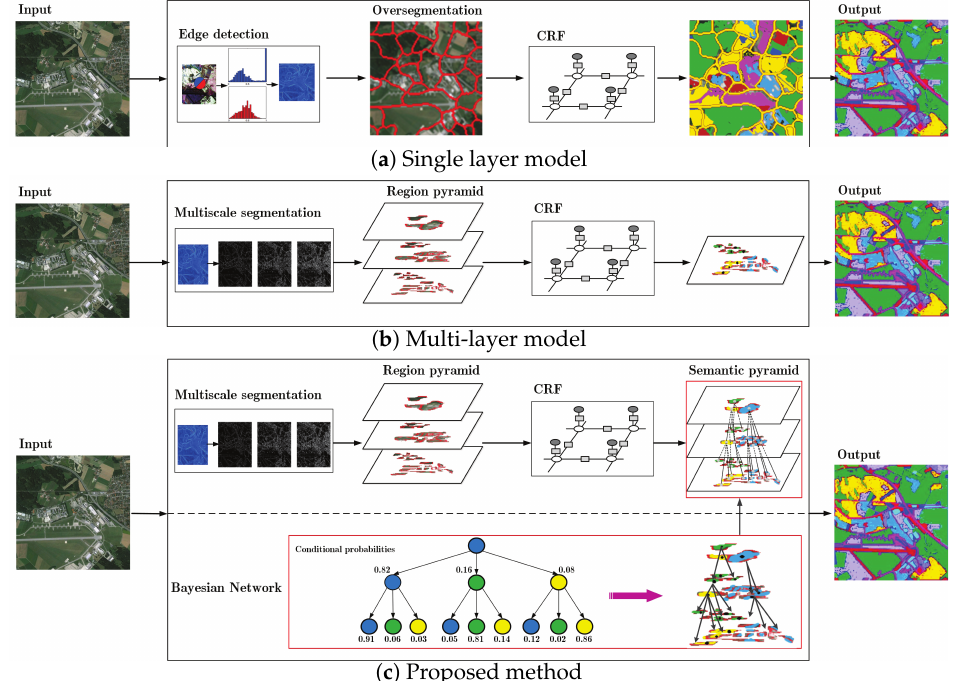
Figure 1. Comparison between the traditional and the proposed approaches. ( a ) Traditional single-layer model; ( b ) traditional multilayer model; CRF models the spatial relationships among those regions within each layer; ( c ) the proposed method combines CRF with BN into a unified framework, where BN captures the causal dependencies between adjacent layers, and therefore, more prior knowledge is exploited to guide